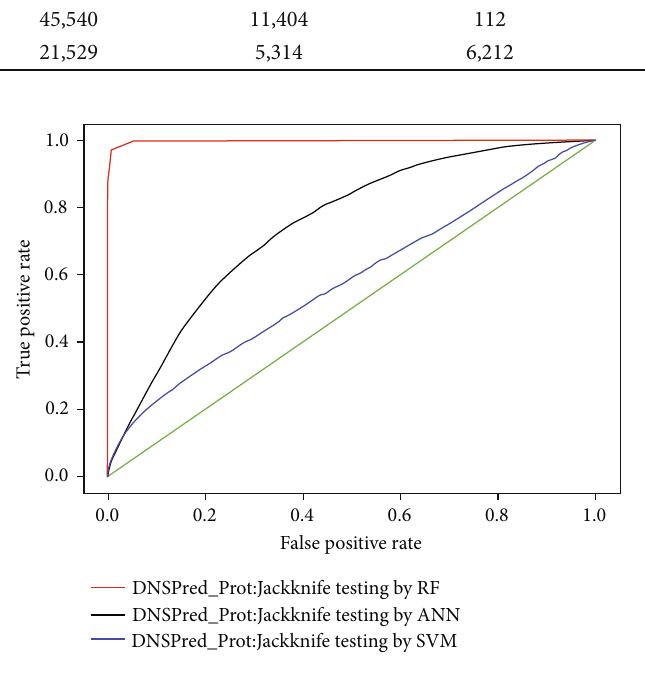
Figure 11: ROC for jackknife testing. Table 6: Confusion matrix obtained from independent